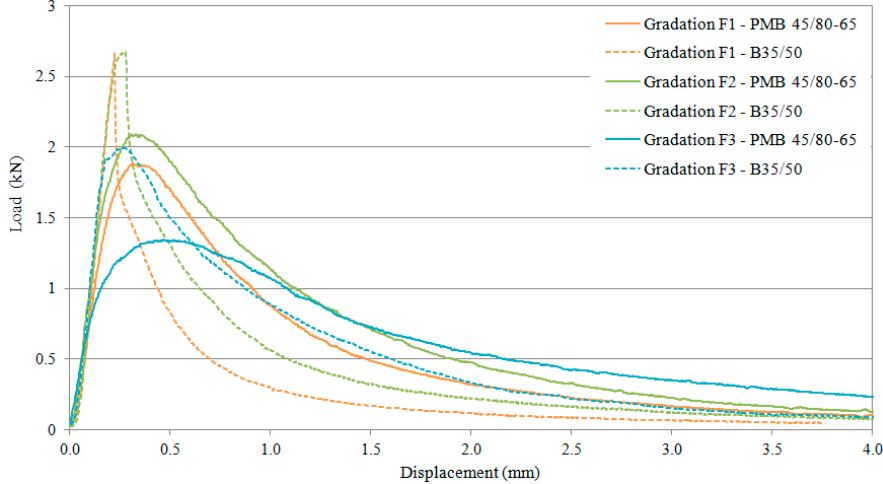
Figure 4. Stress-displacement curve at a test temperature of 5 °C.